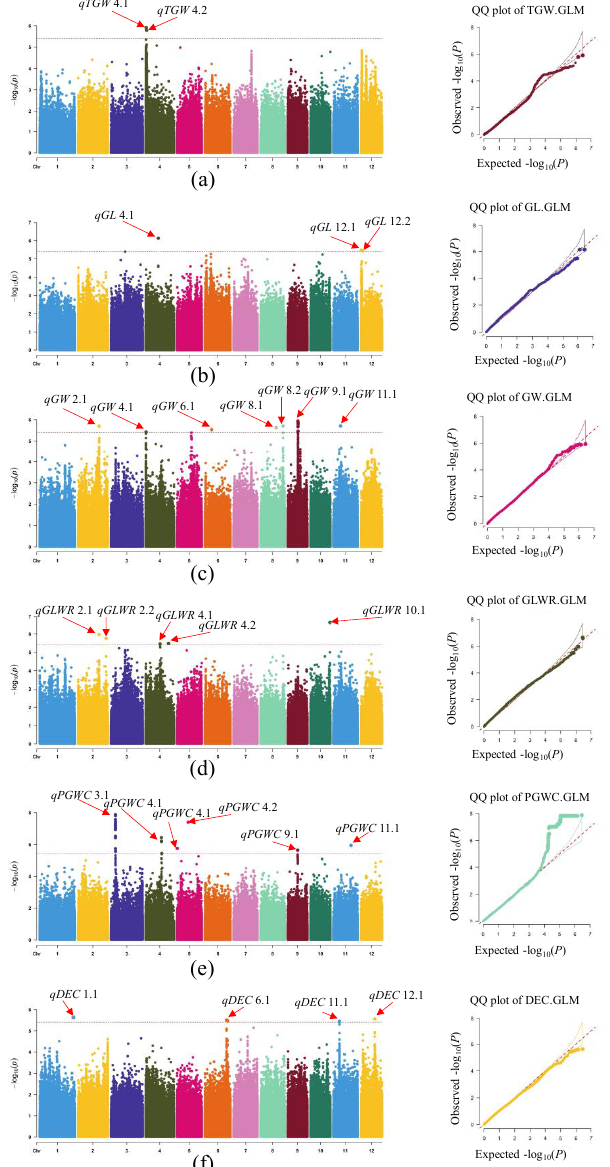
Figure 3. Genome-wide association plots of TGW, GL, GW, GLWR, PGWC and DEC in rice population plotted using the generalized linear model. The Manhattan map of genome-wide scans shows the − log10( p ) values corresponding to the location of each of 12 chromosomes. Red solid lines represent the whole genome significant threshold p = 3.9 × 10 − 6 . Red arrows indicate QTLs qTGW4.1 (rs4_608507), qTGW4.2 (rs4_1225773), qGL4.1 (rs4_16205291), qGL12.1 (rs12_225117), qGL12.2 (rs12_1188996), qGW2.1 (rs2_26502715), qGW4.1 (rs4_502118), qGW6.1 (rs6_8695272), qGW8.1